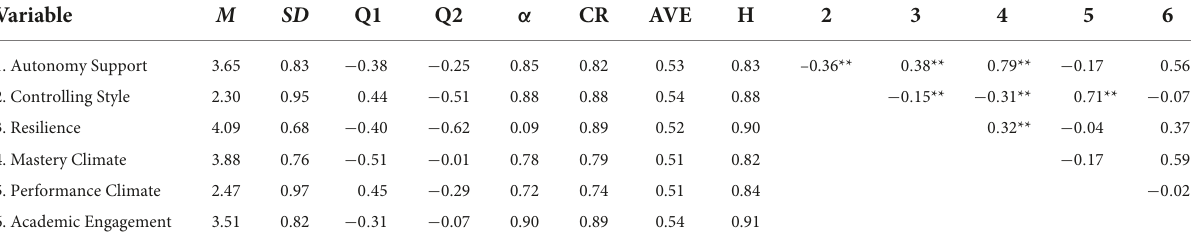
TABLE 1 Descriptive statistics and correlation between